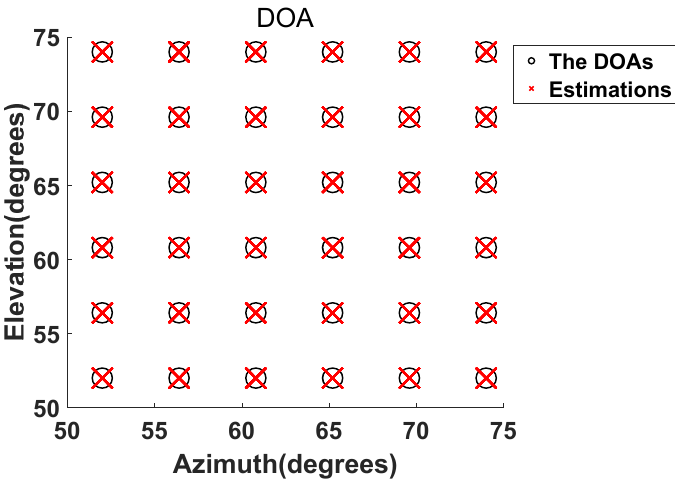
Figure 5. Estimations of 36 sources.